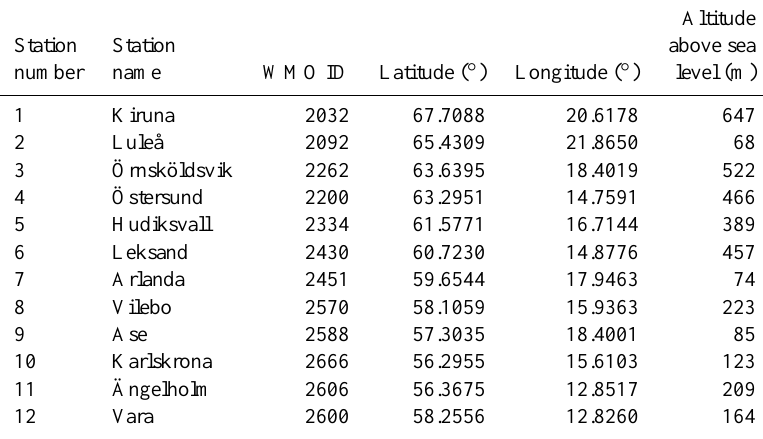
Table 1. Listing of weather radar stations over Sweden.